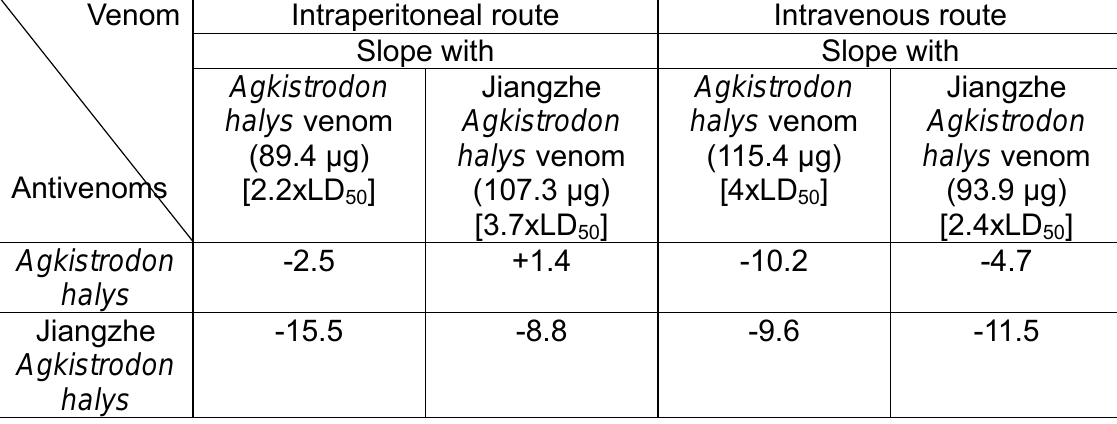
Table 7: Anti-lethal toxin titer of Jiangzhe Agkistrodon halys antivenom against 10 L+ leveled Agkistrodon halys (Japan) venom